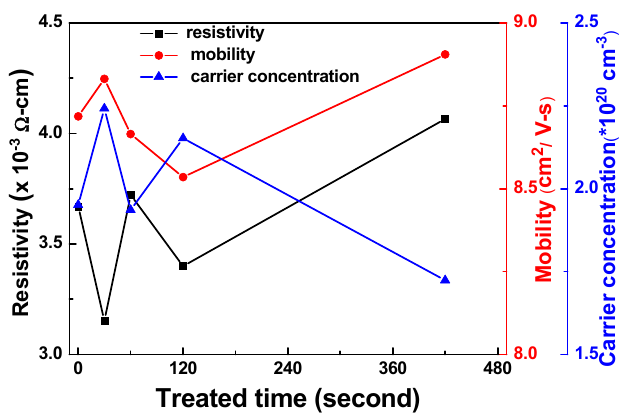
Figure 7. Hall measurement of FZO films as a function of O 2 plasma pretreatment time.